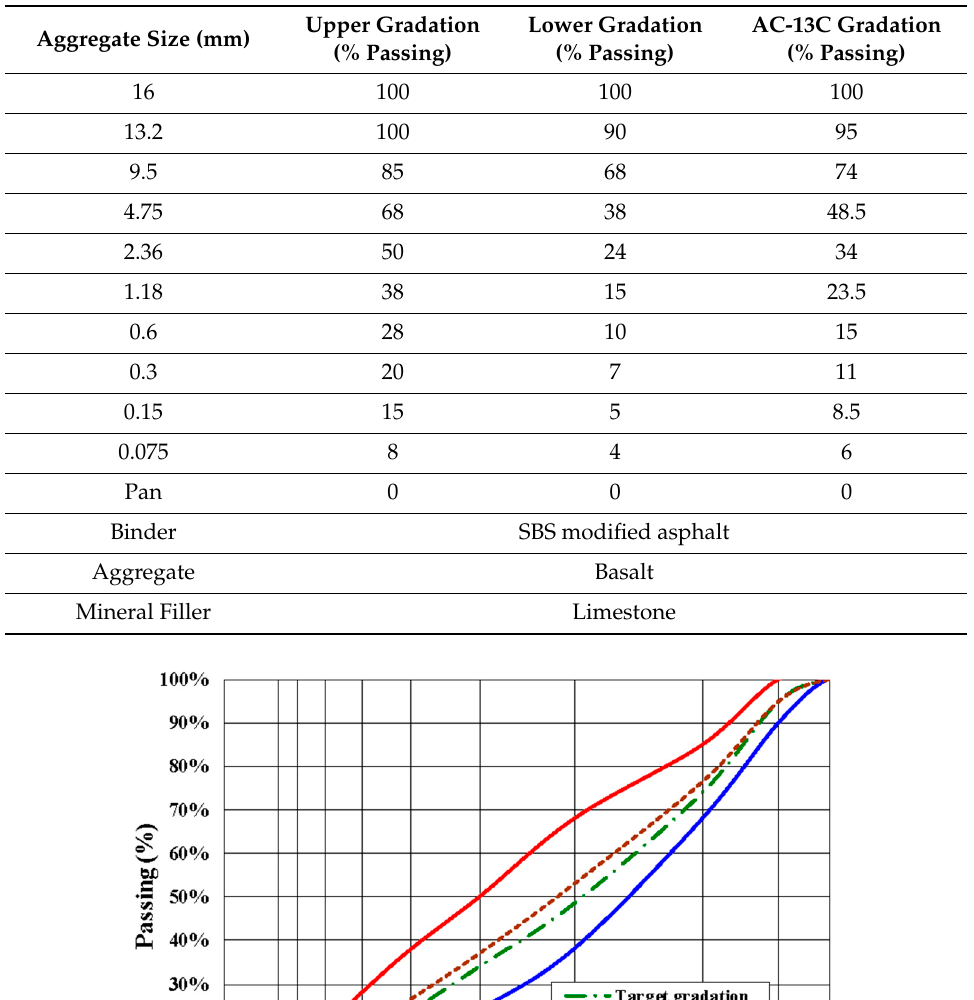
Table 4. Summary of AC-13C mixture gradation.